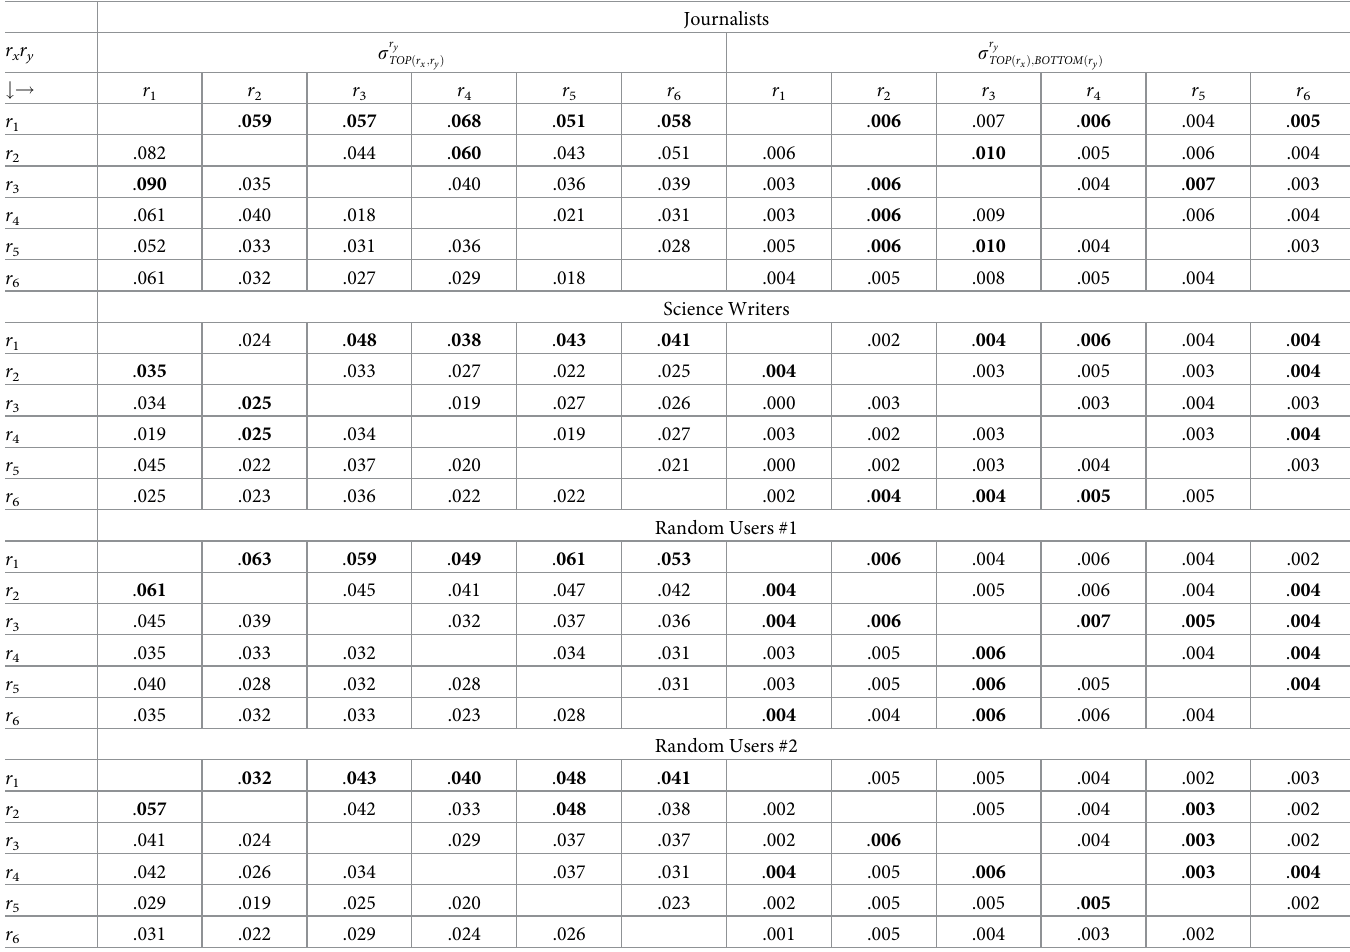
Table 7. Pulling power of primary topics that are also primary elsewhere vs “average” primary / nonprimary topic. On the left, s r y sets. On the right, s r y . The highest value per column is in bold. TOP ð r x Þ ; BOTTOM ð r y Þ